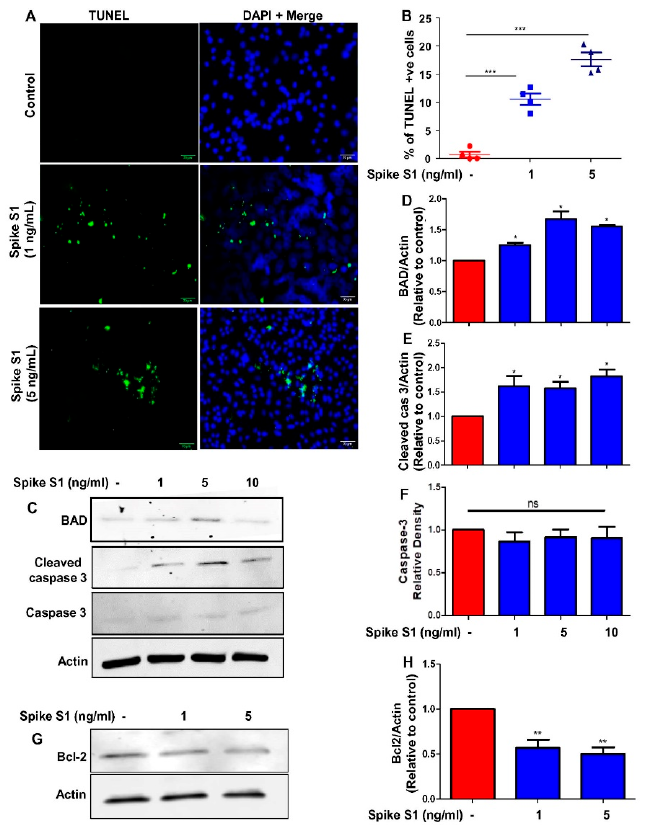
Figure 3. Recombinant SARS-CoV-2 spike S1 induces apoptosis in human A549 lung cancer cells. A549 cells were treated with different doses of spike S1 protein for 12 h under serum-free condition followed by monitoring apoptosis by TUNEL ( A ). TUNEL positive cells were counted in 10 varied images per group and plotted as percent of total cells ( B ). ( C ) Cells were immunoblotted for apoptosis-related molecules (BAD, caspase 3 and cleaved caspase 3). Actin was run as a loading control. For original blots, please see Figure S1. Bands were scanned and values (( D ), BAD/Actin; ( E ) cleaved caspase 3/Actin; ( F ) caspase 3/Actin) presented as relative to control. ( G ) Cells were immunoblotted for survival-related molecule (Bcl 2 ). Actin was run as a loading control. ( H ) Bands were scanned and values (Bcl 2 /Actin) presented as relative to control. Results are mean ± SD of three different experiments. * p < 0.05; ** p < 0.01; *** p < 0.001; ns, not significant. Scale bar = 22 µm.